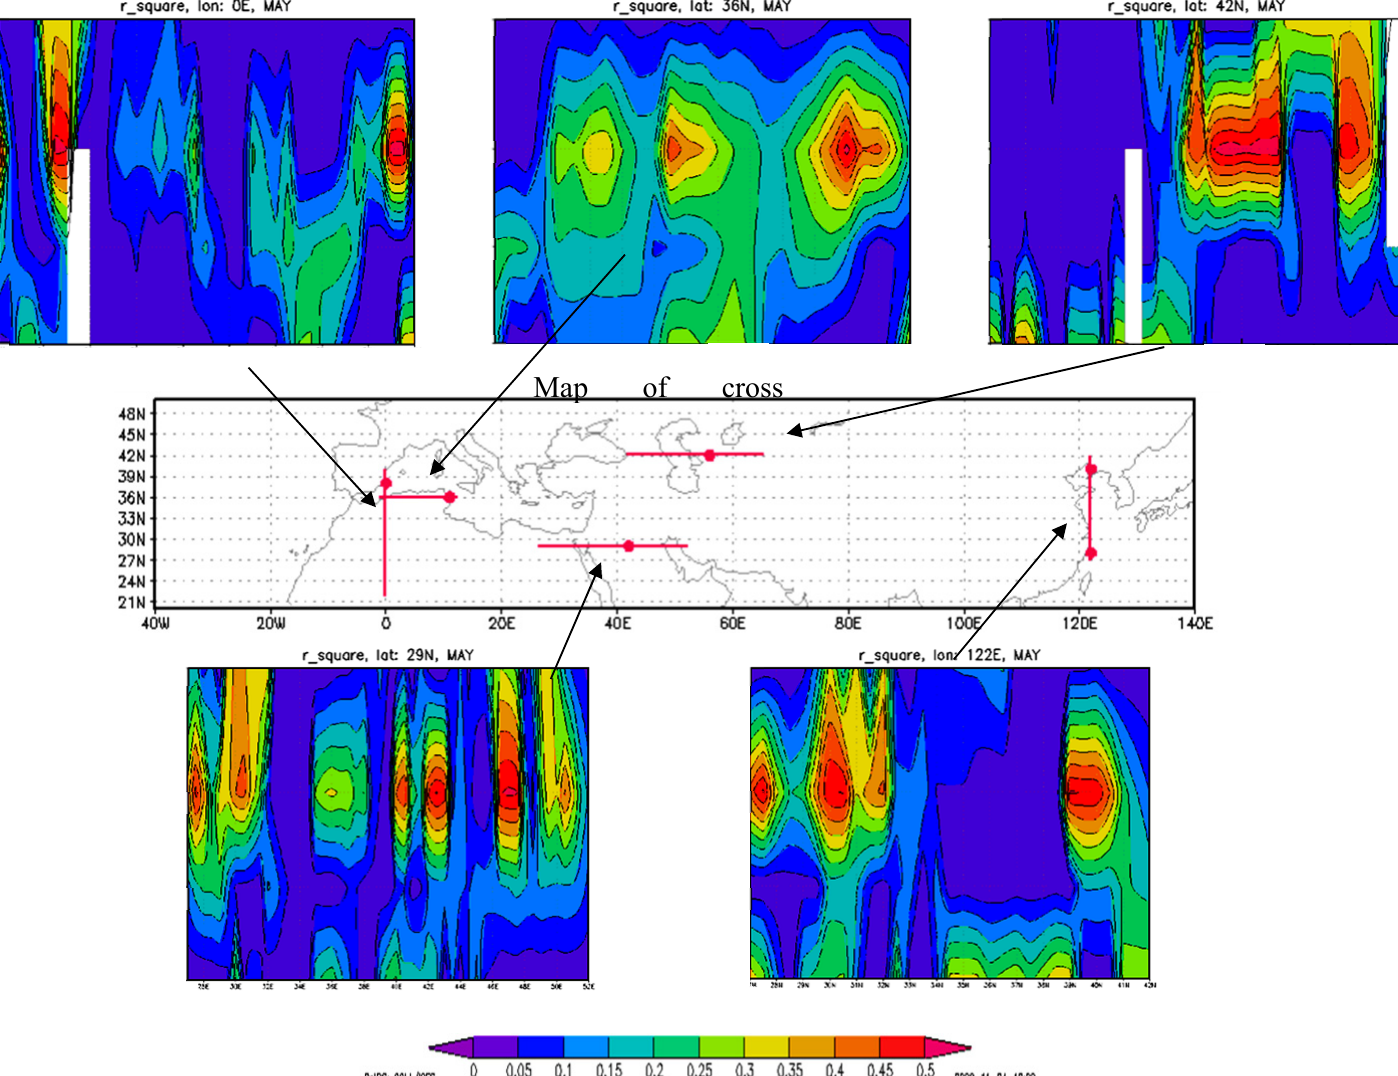
Figure 4. Map of zonal and meridional vertical cross-sections of R 2 level. Missing values (white spots) represent R 2